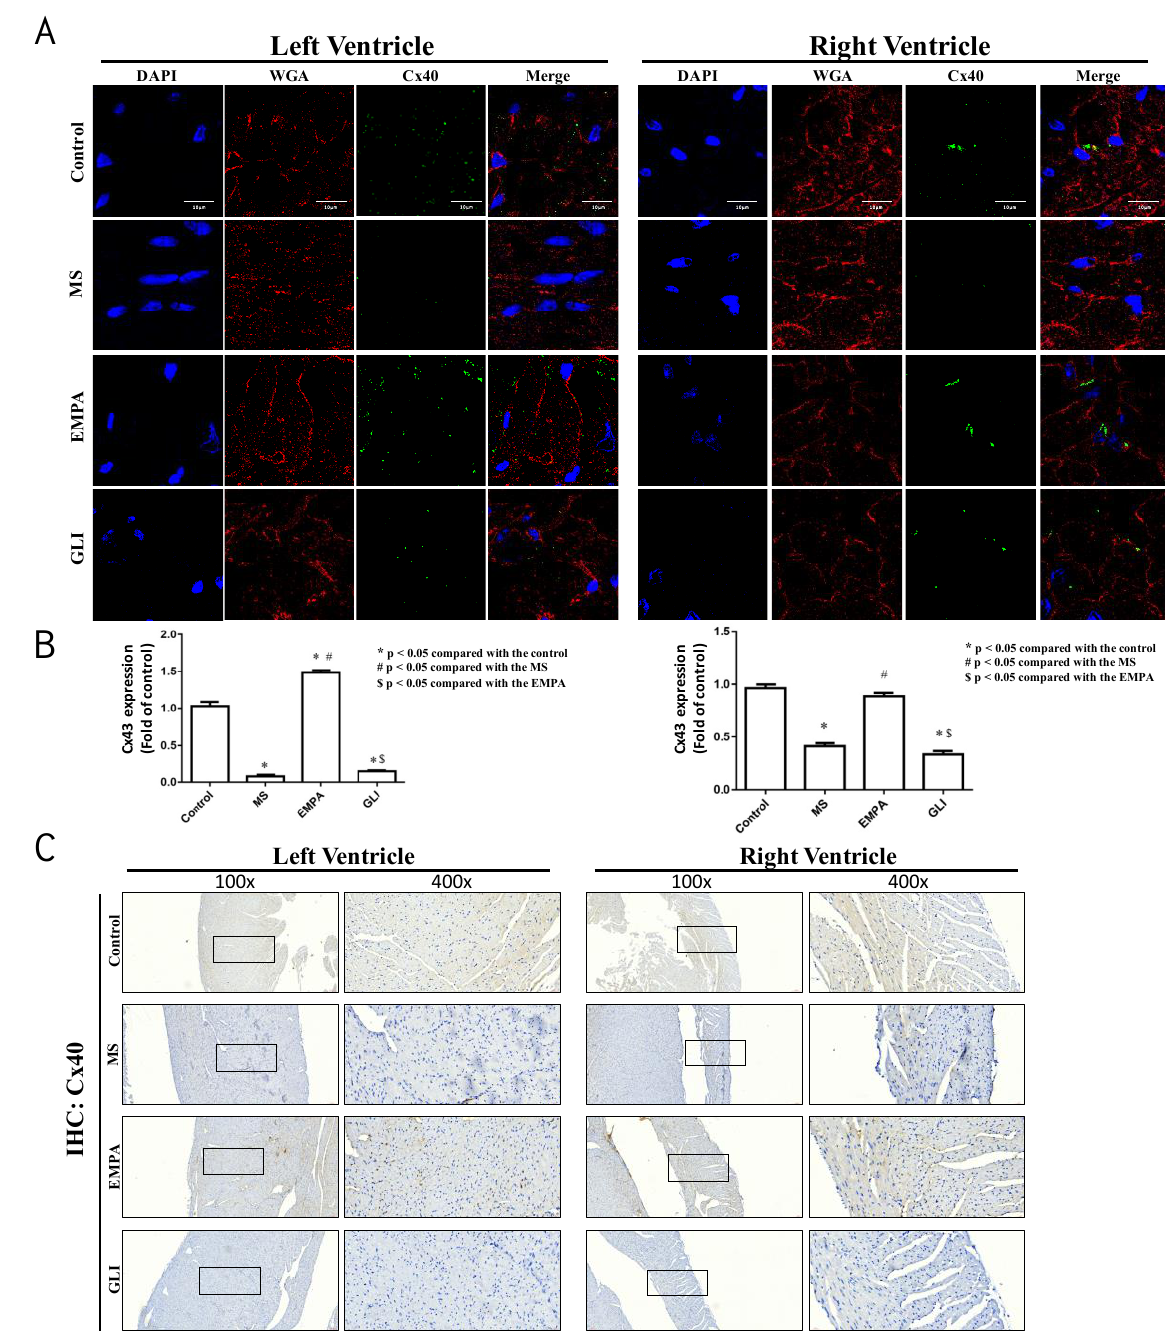
Figure(cid:9)3 －放大 2 倍